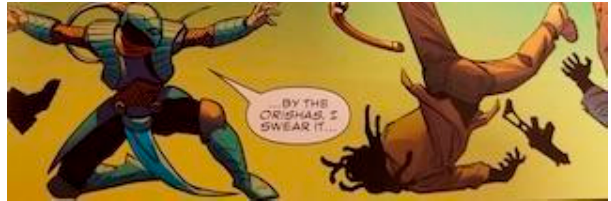
Figure 1. Orishas in Black Panther , 2016.